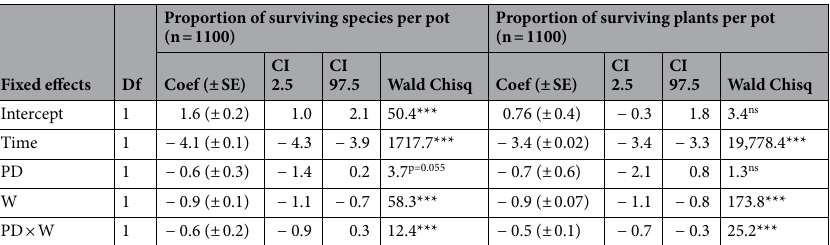
Table 2. Generalized linear mixed models (GLMMs) for the proportion of surviving species and proportion of total plants per pot. Dependent variables were modelled using binomial error distributions and logit link functions. Pot identity (n = 110) and taxonomic composition (n = 4) were included in the model as random factors. Sampling moment (time) was considered as the number of days since the beginning of the experiment and used as a covariate (n = 10) to statistically control for the effect of time. Phylogenetic diversity (PD) and water availability (W) were used as fixed factors. Type III Wald Chi-square tests were performed to estimate significance. Number of observations are shown for each dependent variable. Df degrees of freedom, Coef. Coefficient, SE standard error, CI confidence interval, ns not significant. * p < 0.05; ** p < 0.01; *** p <